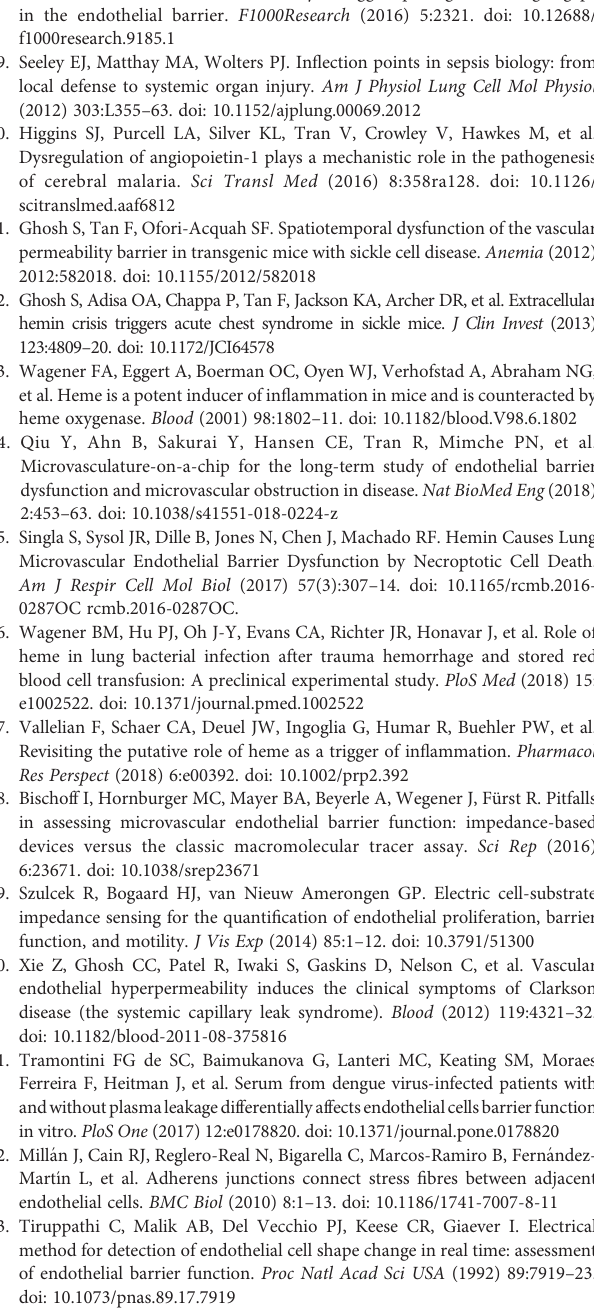
SUPPLEMENTARY FIGURE 1 | Exploration of the effects of NaOH and hydroxyurea (HU) on EB. In (A) , different concentrations of NaOH, which was the vehicle used to dilute heme, were used under the same experimental conditions. Each line represents the mean ± SEM of the normalized resistance of HUVECs stimulated with either NaOH or thrombin used as a positive control. Normalized resistance wasmeasured by ECISat 4,000Hz.As shownin the upperpanel, NaOH at different concentrations did not affect EB. In (B) , data from SCD patients used in Figure 3 were subdivided according to the use or not of hydroxyurea (HU). No differenceinECISreadingsafterhemestimulation couldbedetected betweenthese two subgroups. Kruskall Wallis and Dunn ’ s